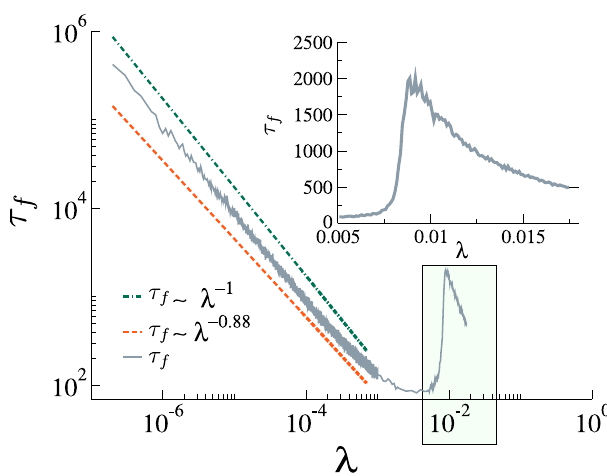
Fig. 6 Lifespan as a function of the spreading rate λ . Results for δ = 1, α = 0.5 on an uncorrelated power-law network with P ( k ) ~ k − γ with γ = 2.25, N = 10 6 . In the main panel, we show a wide range of λ , emphasizing the sub-critical behavior, while in the inset we show the peak that suggests a continuous phase transition. The blue curve (dot dashed line) follows τ f ~ λ − 1 and the orange curve (dashed line) follows τ f ~ λ − 0.88 , obtained from a fi tting of the lifespan obtained using Monte Carlo simulations (the gray curve).